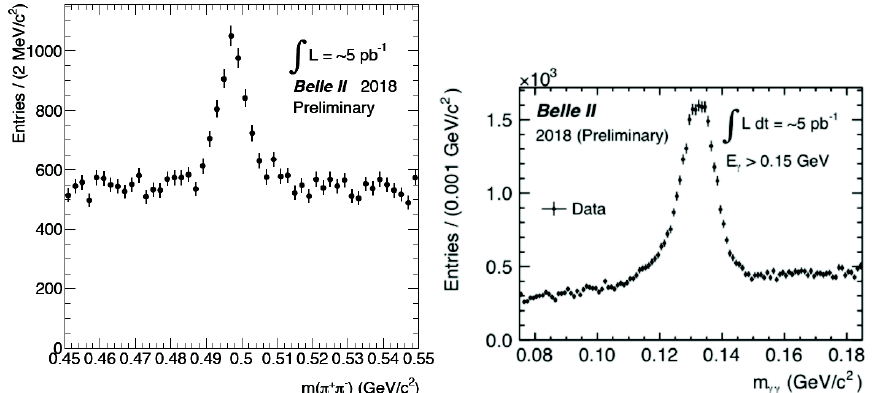
Figure 1. (left) Preliminary plot of the invariant mass distribution of the π + π − system on 5 pb − 1 inte- grated luminosity with Belle II data set. A clear peak is shown at the K 0 mass distribution of the γγ system on 5 pb − 1 integrated luminosity with Belle II data set. A clear peak is shown at the π 0 nominal mass, after applying a cut on the photon energy larger than 150